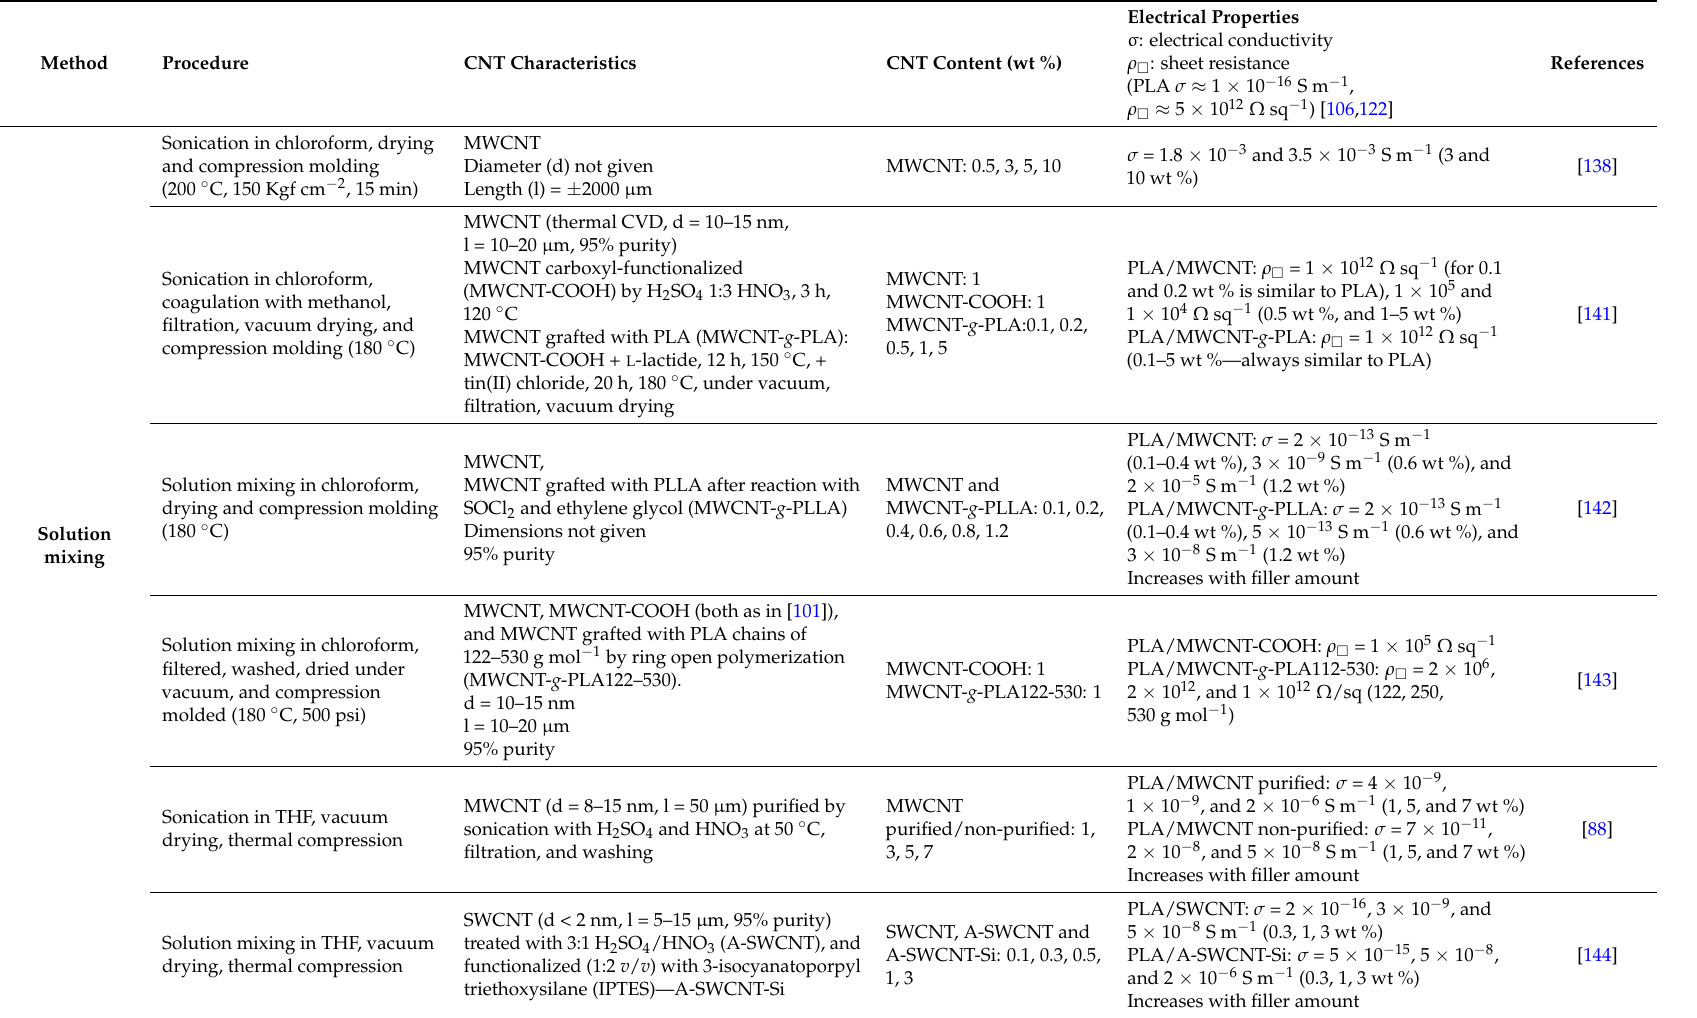
Table 2. Electrical properties of PLA/CBN composites in comparison with non-modified PLA. Production methods and CBN